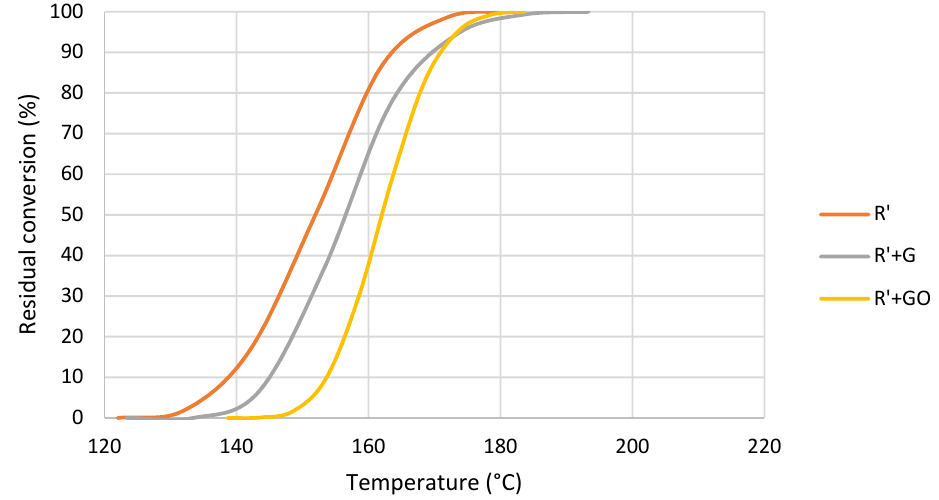
Figure 11. Conversion curves at 10 °C/min of R’ and R’+GBN after UV exposure.